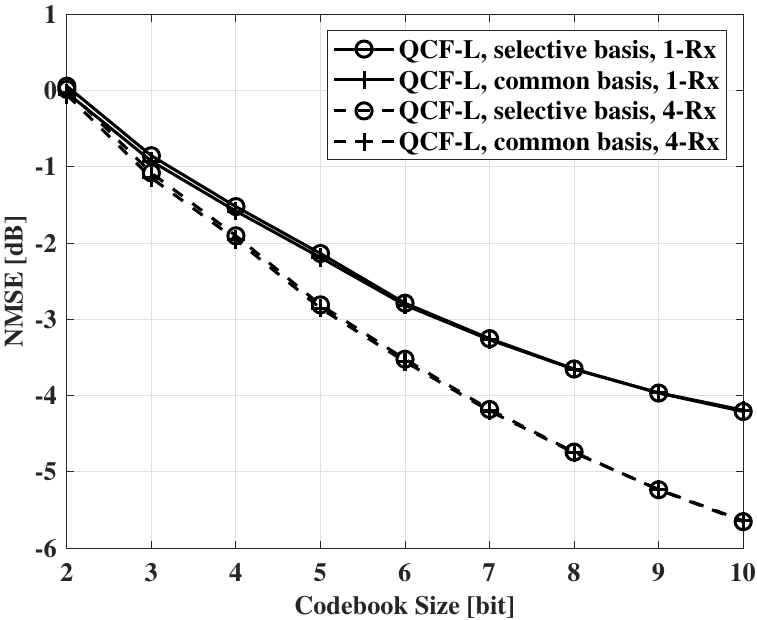
Figure 3. NMSE measurements according to codebook size, SNR = 10 dB, N t = 32, and N r =